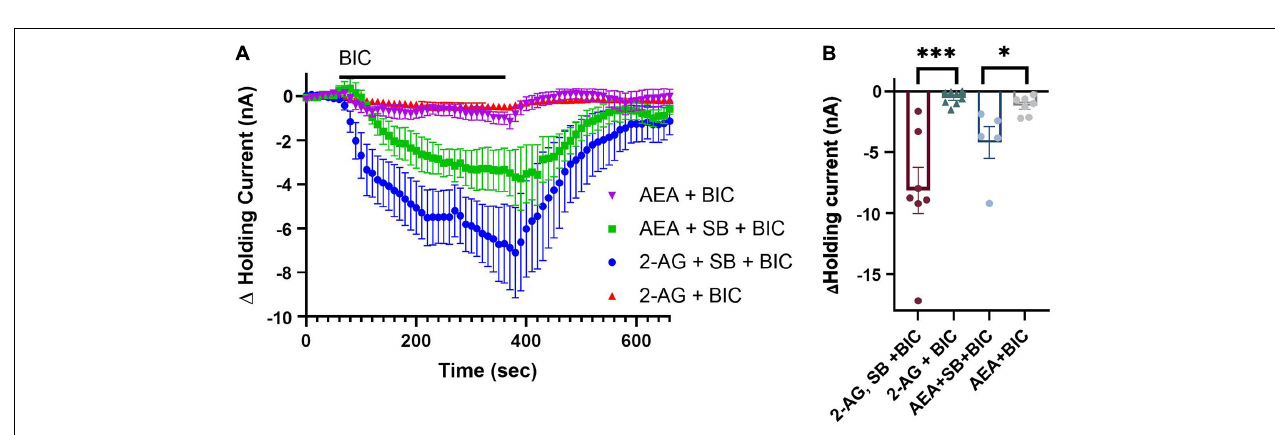
FIGURE 4 | Role of DAGL, TRPV, and CB1 in mediating N cell HFS-induced depression of tonic inhibition. (A) Pretreatment with 10 µ M SB 366791 (SB) prior to N Cell HFS restore the BIC-induced negative shift in P cell holding current. 10 µ M THL/Orlistat (DAGL inhibitor) and 10 µ M AM251 (CB1 reverse agonist) did not prevent N cell HFS from depressing tonic inhibition. (B) In terms of peak change in holding current significant differences were observed between the THL + HFS + BIC vs. the DMSO + BIC and SB + HFS + BIC groups ( ∗ indicates p < 0.05). Significant differences were also observed between the AM251 + HFS + BIC vs. the DMSO + BIC and SB + HFS + BIC groups. All data is shown as mean ± SE.